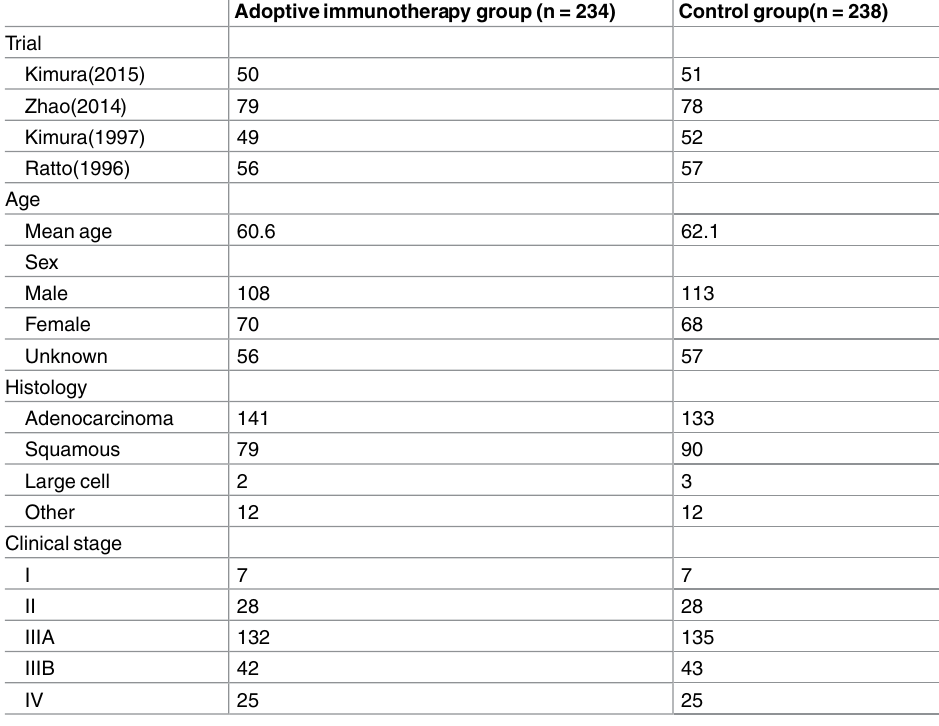
Table 2. Characteristicsof Included Studiesfor